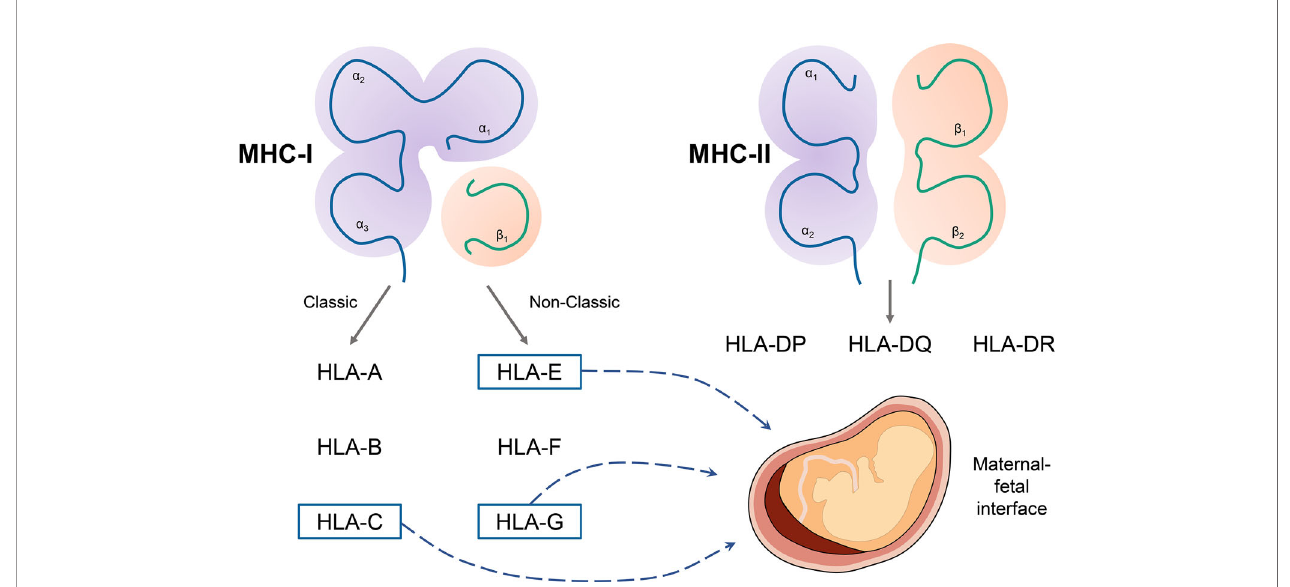
FIGURE 2 | The classi fi cation of major histocompatibility complex (MHC) molecules and main molecules in maternal-fetal immunity. MHC includes MHC class I and II molecules. Classic MHC class I molecules include human leukocyte antigen (HLA)-A, HLA-B, and HLA-C. The non-classic MHC class I molecules include HLA-E, HLA-F, and HLA-G. MHC class II molecules include HLA-DR, HLA -DP, HLA -DQ. HLA-C, HLA-E, and HLA-G play a signi fi cant role in immune tolerance in the maternal-fetal interface.